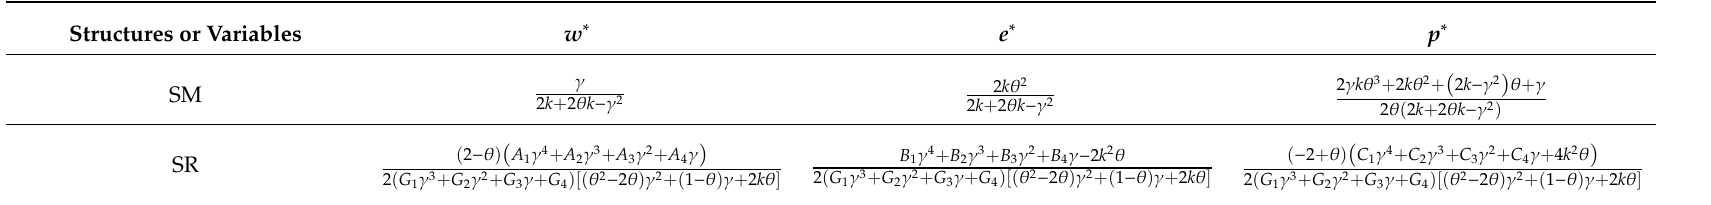
Table 2. The decisions of the supply chain under two di ff erent power structures with a revenue-sharing contract. Structures or